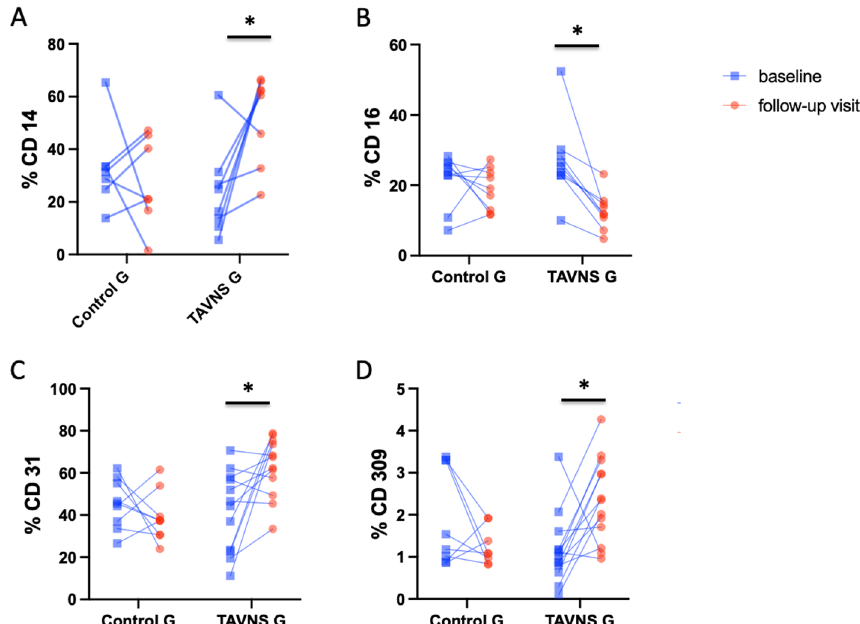
Fig. 4 Circulating monocytes and endothelial cells percentages in control and TAVNS groups at baseline and after 8 weeks of follow-up. A CD14 + classical monocytes ( * p = ( D ) CD309. + endothelial progenitor cells ( * p =